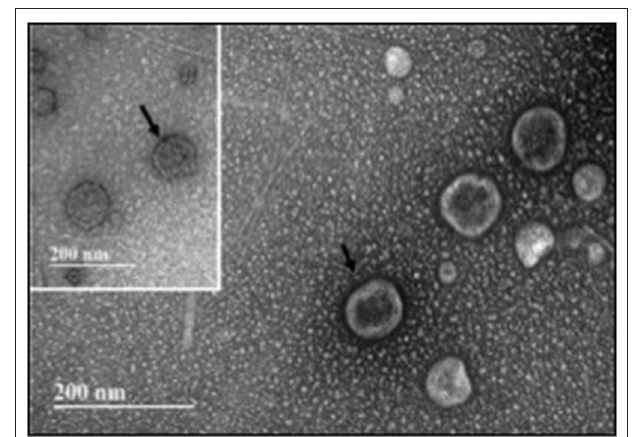
FIGURE 7 | Transmission electron microscopy (TEM) of exosomes isolated from hBM-MSCs after an initial 8 days of rotisserie culture and followed by oscillatory flow conditioning in our bioreactor for 2 weeks. Insert: Immunogold labeling with CD 9 antibody. Arrow indicates site of CD9-Immunogold labeling. Scale bar =